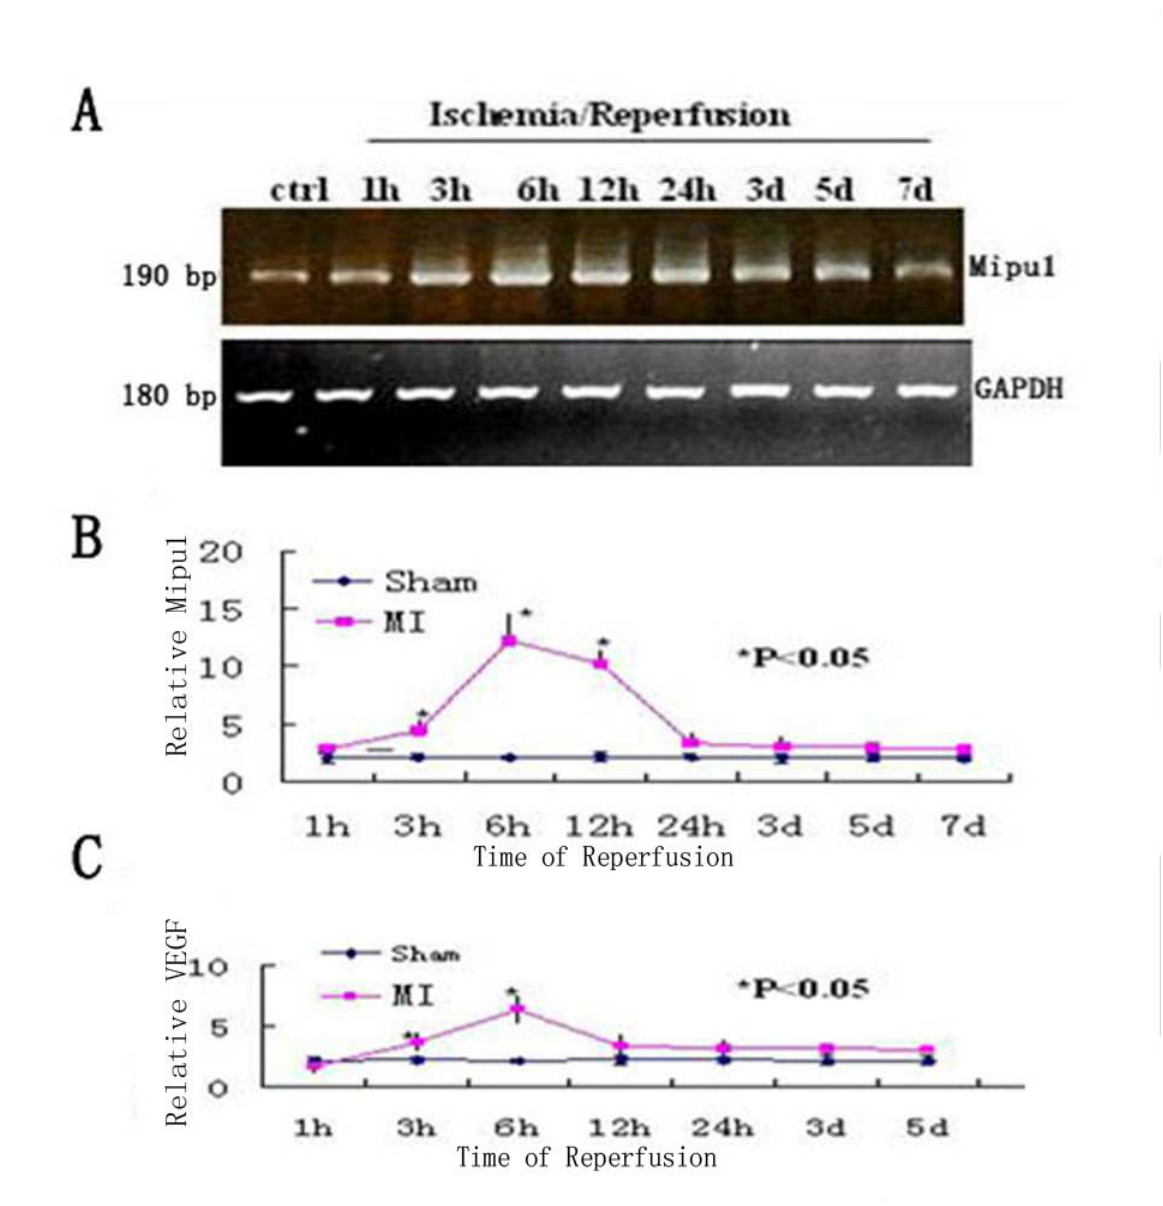
Figure 2. Time-dependent changes in the expression levels of Mipu1 and VEGF in the infarcted heart. A: Agarose gel electrophoresis was used to show the results of the samples at each time point analyzed by RT-PCR. B: Quantitative real-time RT-PCR analysis of Mipu1 mRNA in the infarcted hearts; C: Quantitative real-time RT-PCR of VEGF mRNA in the infarcted hearts. * Statistically significant versus sham, P < 0.05,